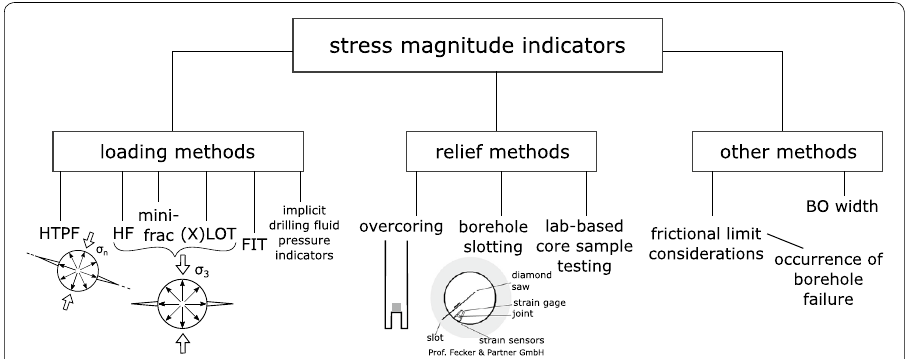
Fig. 2 Stress magnitude indicators. Overview of indicators relevant to the stress magnitude database of Germany and adjacent regions. HF hydraulic fracturing, HTPF hydraulic testing of pre-existing fractures, (X) LOT (extended) leak-off test, FIT formation integrity test, BO borehole breakout, σ n normal stress, σ 3 minimum principal